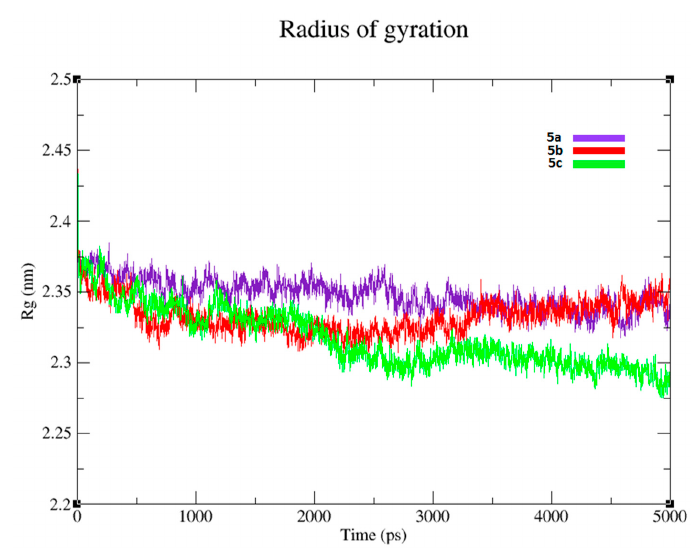
Figure 10. Radius of gyration ( R g ) graph of prodrugs ( 5a – c ).